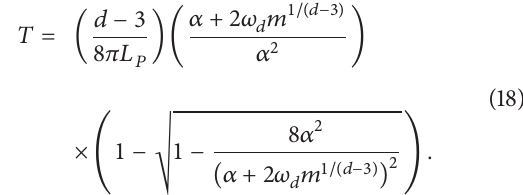
Figure 1: Temperature of a black hole as a function of mass, for different numbers of space-time dimensions with 𝛼 = 1 , and in the presence of GUP ∗ . Mass is in the unit of the Planck mass and temperature is in the unit of the Planck energy. Figure 2: Black hole temperature as a function of mass for arbitrary numbers of space-time dimensions and in presence of GUP ∗ . On the left hand side of the figure, from bottom to top, the curves are corresponding to 𝛼 = 0.5 , 1, and 1.5,